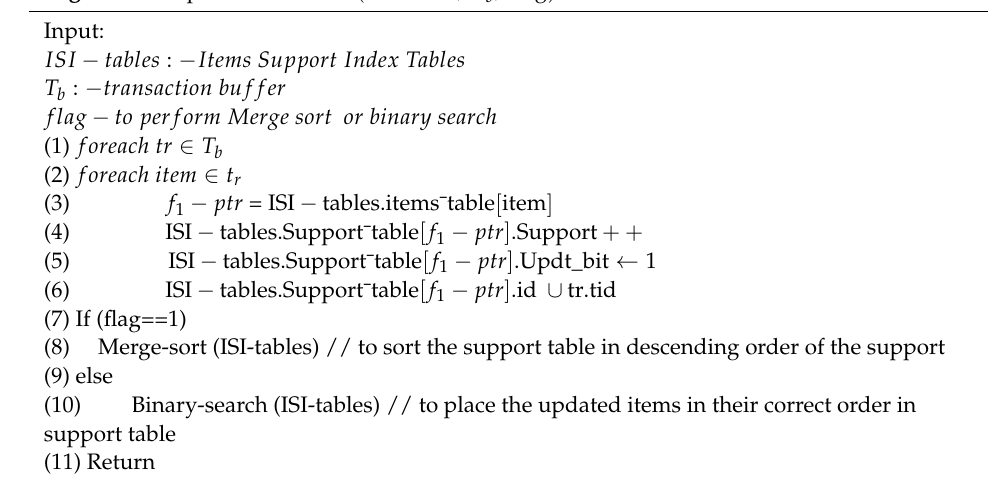
Algorithm 2 update_ISI_tables ( ISI-tables, T b , flag